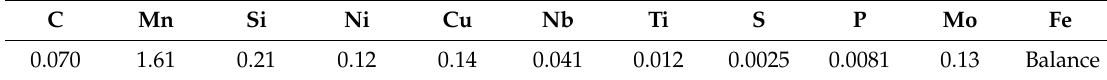
Table 1. Chemical composition in wt% of X80